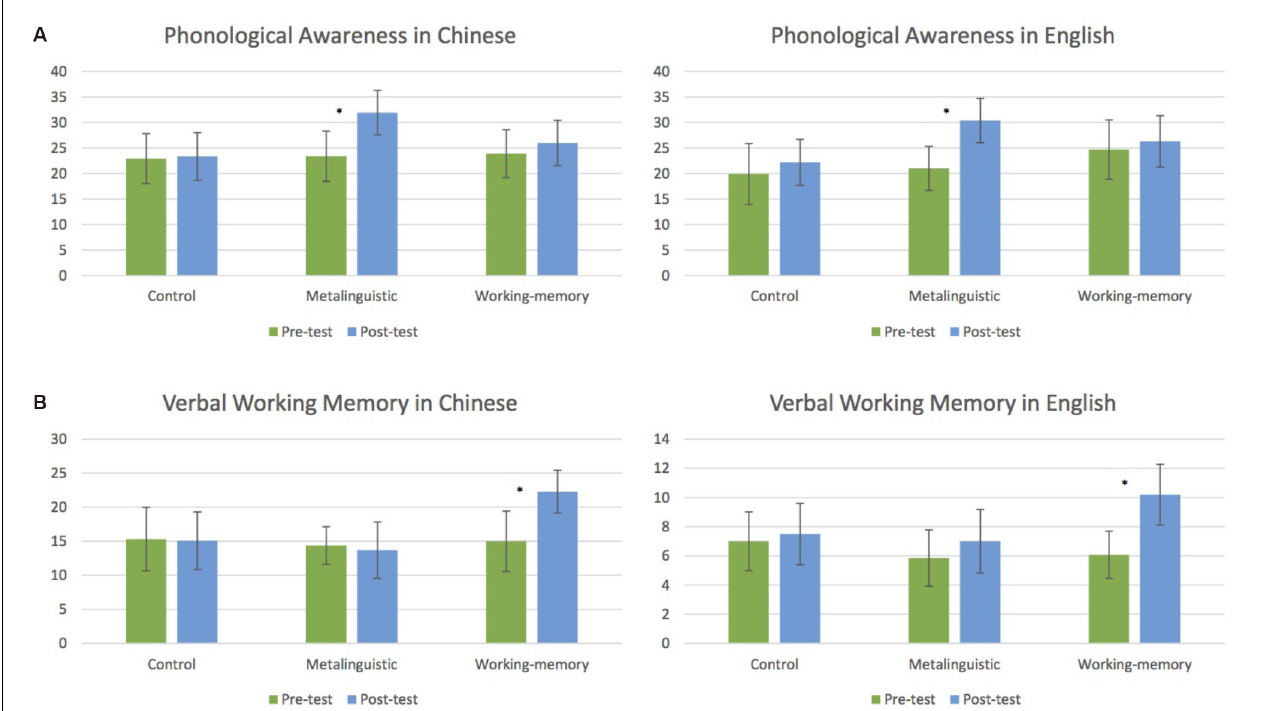
FIGURE 2 | Pre(green)–post(blue) training effects in Chinese and English for phonological awareness (A) and verbal working memory (B) for the three groups (control group, metalinguistic training group, and working memory training group). Error bars represent standard deviations. ∗ Indicates significant training effects.